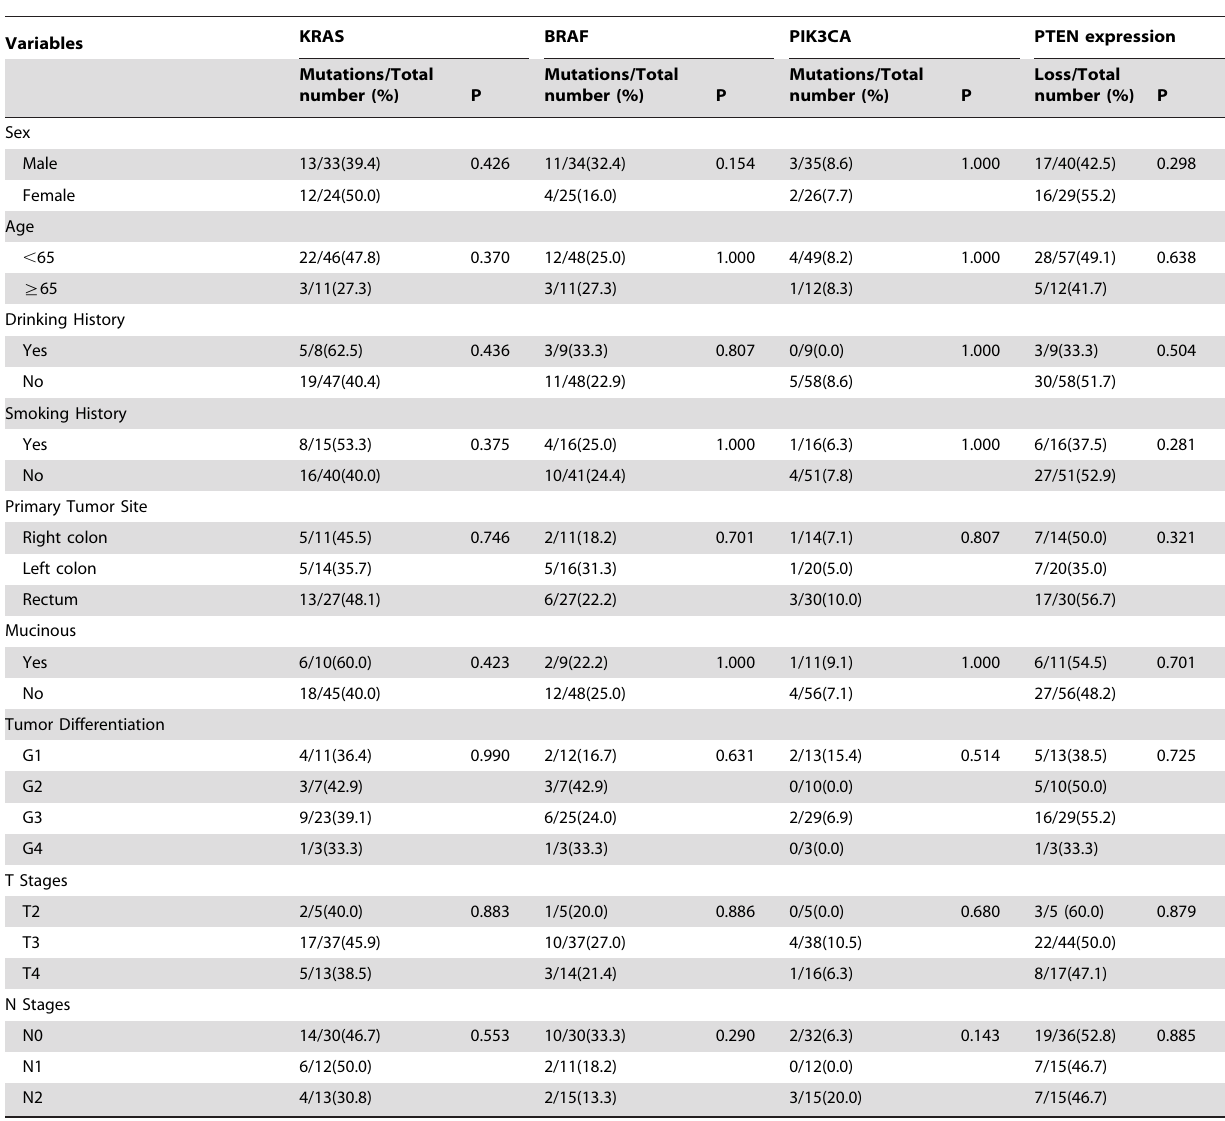
Table 4. Association of KRAS, BRAF and PIK3CA mutations and loss of PTEN expression with clinical and pathologic characteristics.